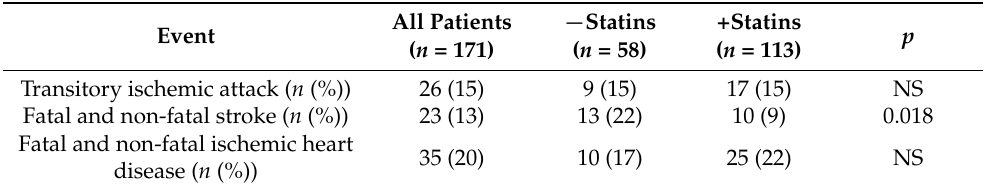
Table 5. Prevalence of newly occurred major cardiovascular events during follow-up in patients who used or did not use statins before carotid artery